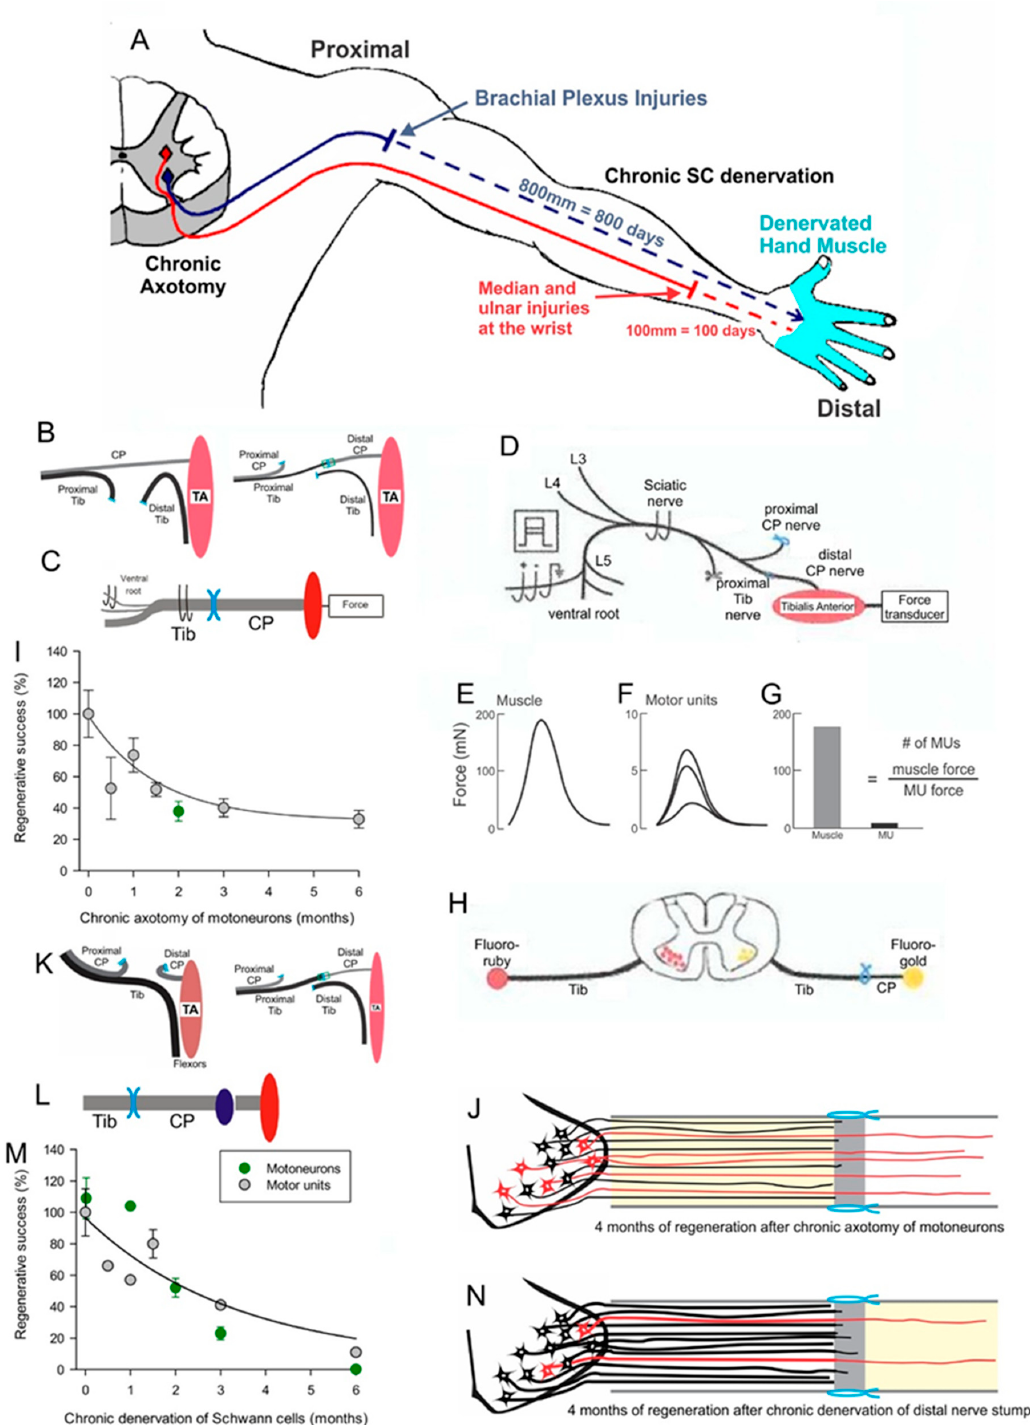
Figure 3. A. Motoneurons remain without targets (chronic axotomy) as they regenerate after proximal nerve injuries such as brachial plexus injuries and Schwann cells (SCs) in the denervated distal nerve stumps remain chronically denervated. At the slow rate of 1 mm/day regeneration rate in human, a year or more will pass for regenerating nerves to reach hand muscles, which are generally believed to atrophy and be replaced by fat ( A ). To isolate the effects of chronic axotomy from chronic denervation, the tibial (TIB) nerve was cut and the stumps sutured to innervated muscle prior to a cross-suture of TIB nerve to freshly denervated common peroneal (CP) distal nerve stump ( B ) and